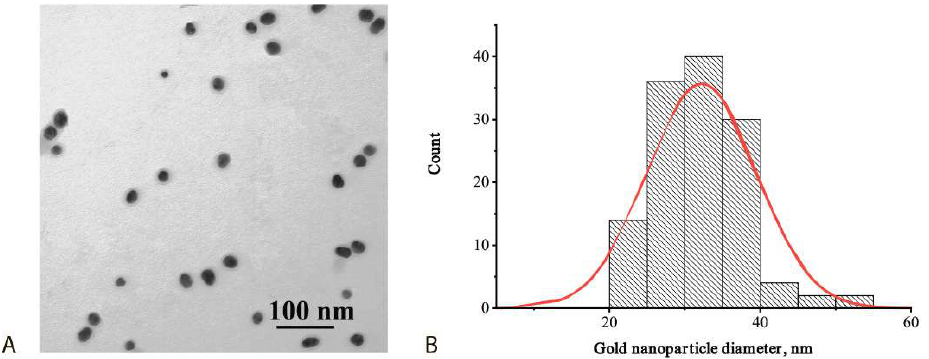
Figure 2. sGNPs: TEM image ( A ) and distribution of diameters ( B ). The obtained sGNPs were conjugated with specific anti-FABP antibodies, F10. The optimal concentration of the antibodies for the conjugation was chosen based on the floc- culation curve [27] and amounted to 10 µg/mL. Optimal conditions for the common ICA with sGNPs were chosen, taking into consideration our earlier development of ICA for FABP [26].